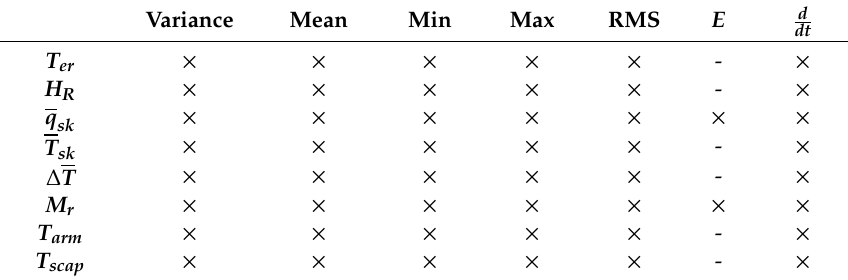
Table 3. Overview of the 54 extracted features ( × = selected).